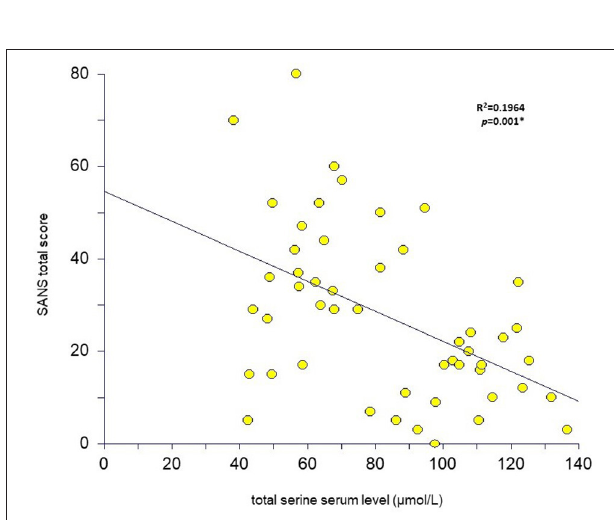
FIGURE 2 | Total serine serum level relation to SANS total score in patients with schizophrenia ( n = 50) (scatter plot with the linear regression curve; * p < 0.05 was considered as significant).